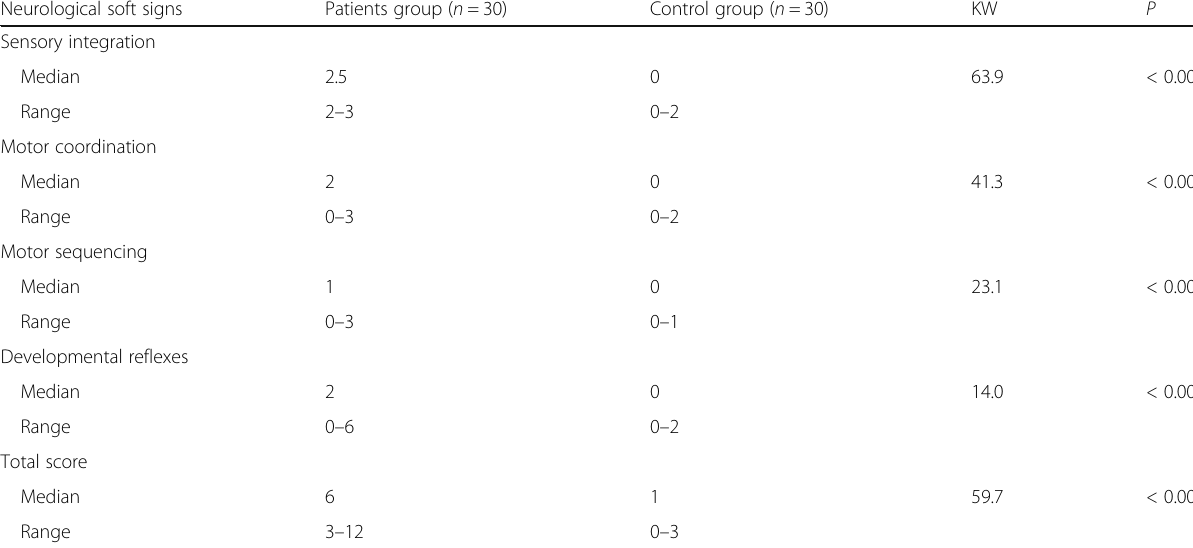
Table 3 Neurological soft signs (NSS) of the studied groups according to Neurological Evaluation Scale (NES) Neurological soft signs Patients group ( n =